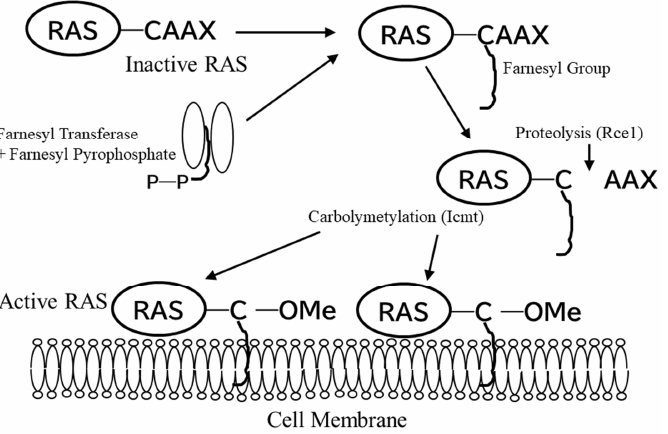
Figure 1. Schematics of farnesylation and membrane association of RAS oncoprotein. RAS processing and membrane association is critical for its transforming activity. C-terminus of RAS protein is first fanesylated followed by proteolysis, carbocxymetylation. C = cysteine, A = aliphatic amino acid, X = any amino acid, Icmt, isoprenylcysteine carboxymetyltransferase; Me, metyl group; P-P, pyrophosphate group; Rce1, RAS-converting enzyme 1.